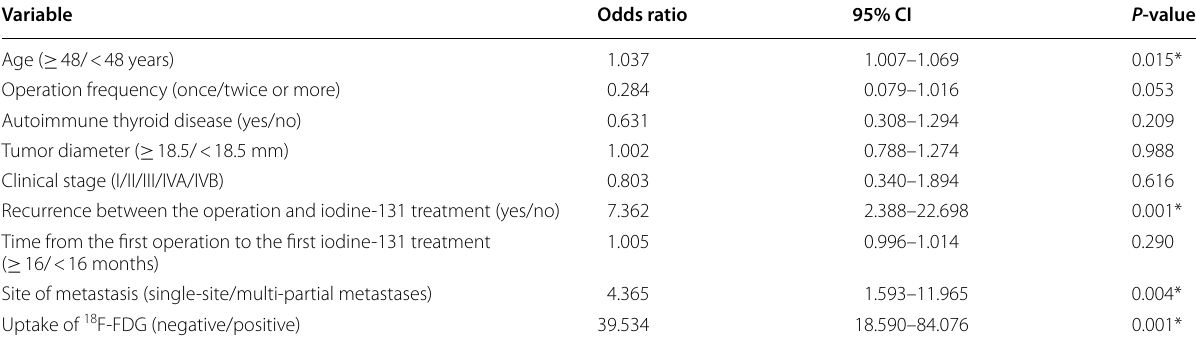
CI, confidence interval; 18 F-FDG, 18 F-fluorodeoxyglucose *